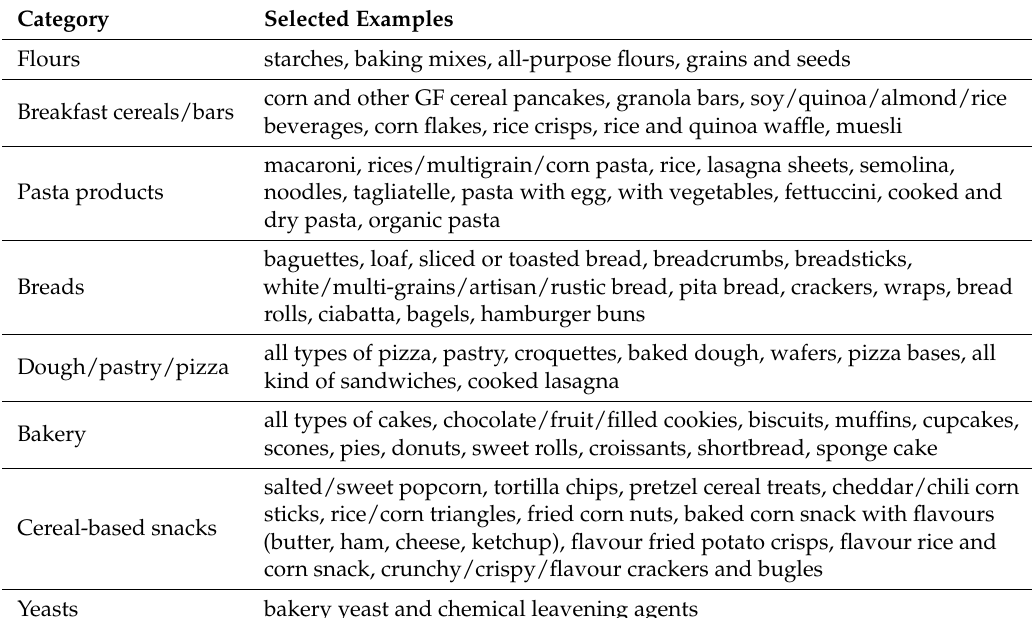
Table 1. Food categories of samples used for gluten